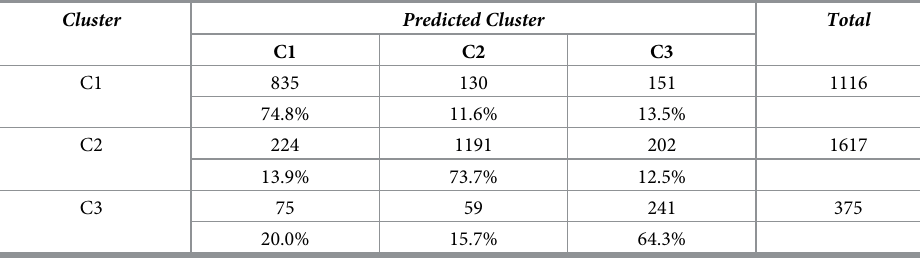
Table 3. A summary of the predictive performance of the multinomial regression model. For a given cluster, the first and second rows show the number and percentage of predicted cases,